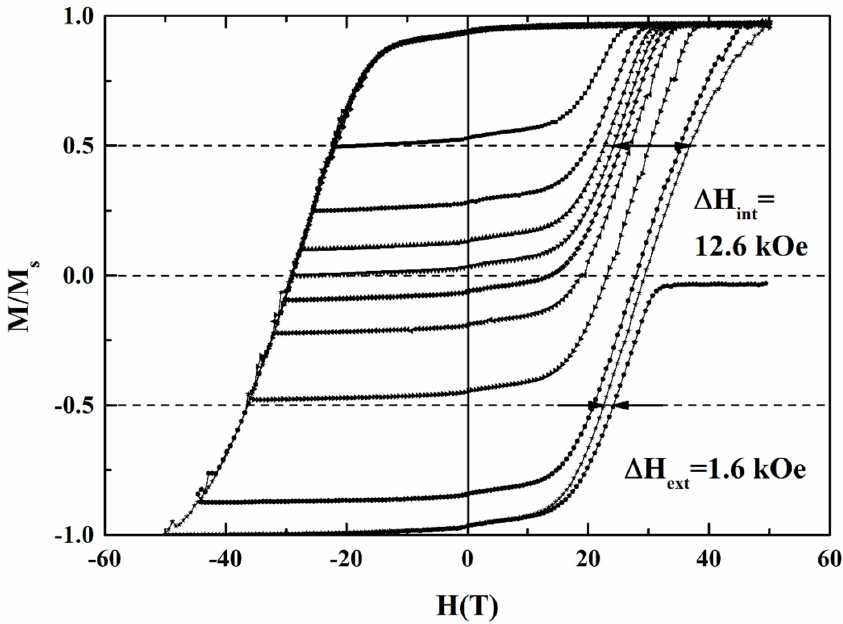
Figure 9. Major and minor loops of the FePt(B, Ag, C)(8 nm)/MgTiON/CrRu film. The minor loop is used to measure intrinsic and extrinsic switching field distribution (SFD).